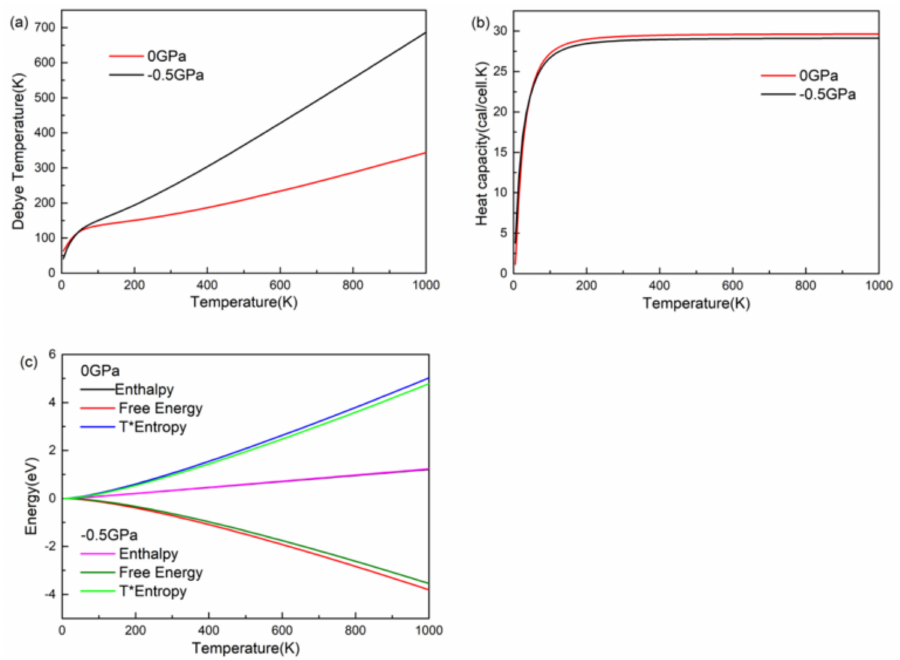
Figure 12. The thermodynamic properties of CsGeI 3 of ( a ) Debye temperature, ( b ) heat capacity, and ( c ) enthalpy, temperature-entropy, and free energy under the pressure of 0 GPa and − 0.5